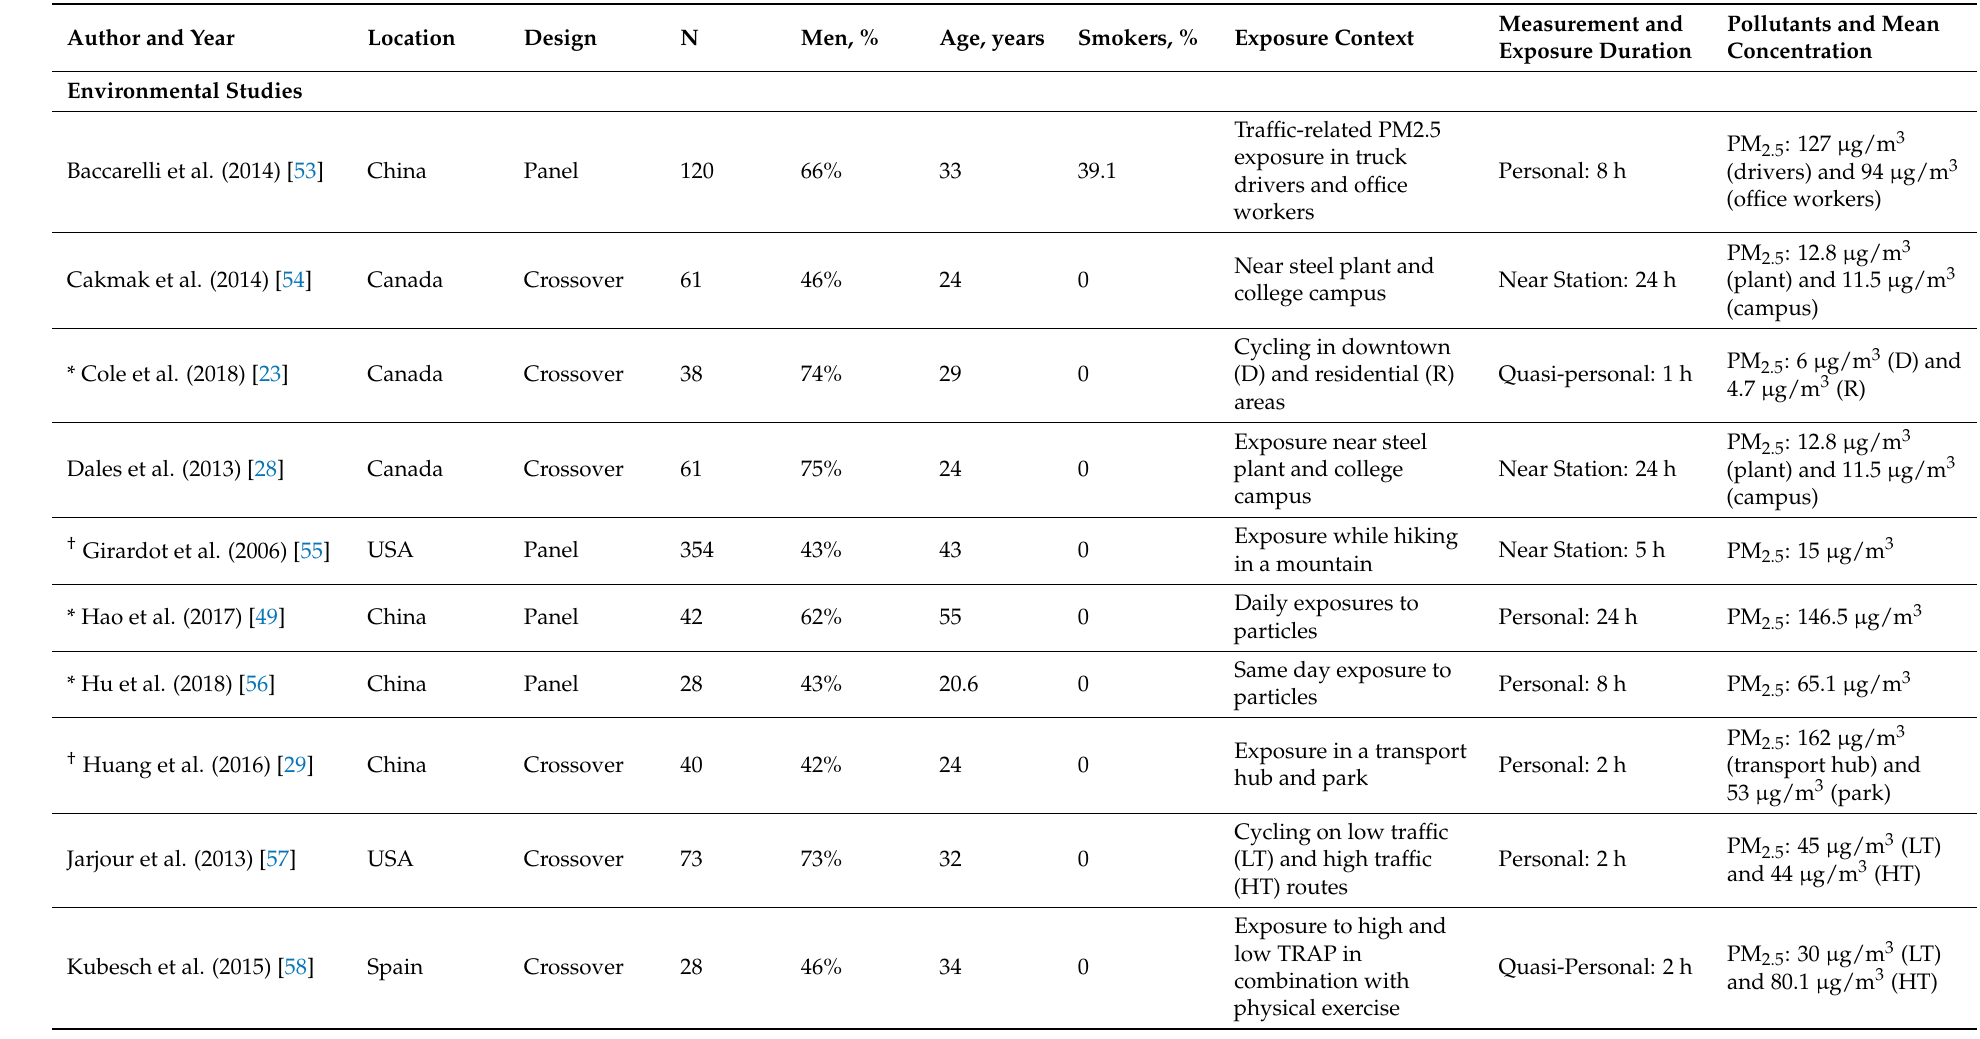
Table 1. Characteristics of the studies included in the systematic review and